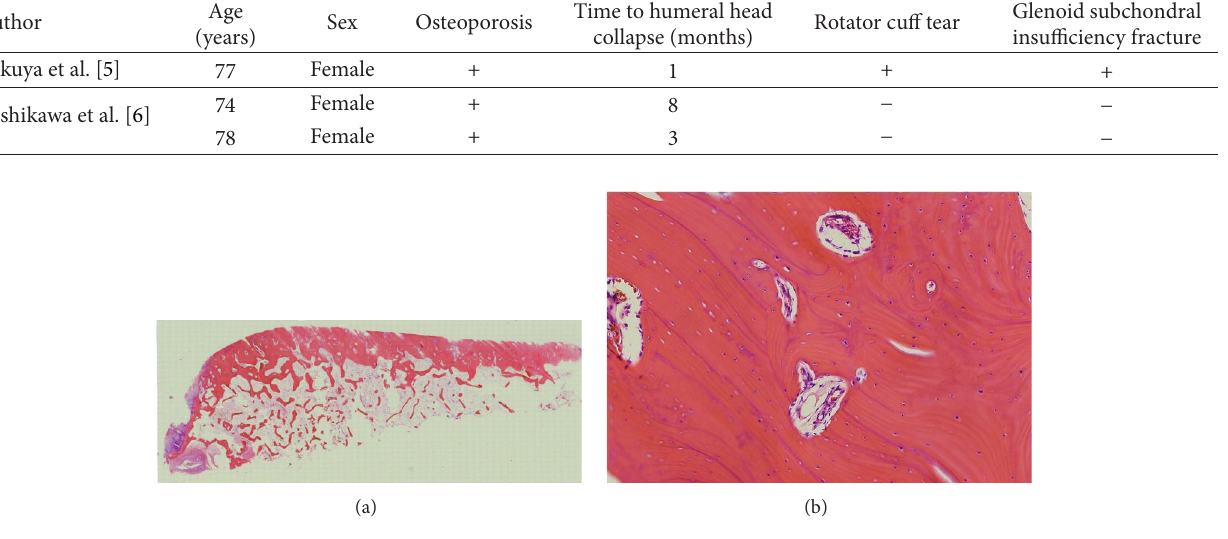
A total shoulder arthroplasty was carried out because the rotator cuff was intact. The excised humeral head had detached articular cartilage and collapsed subchondral